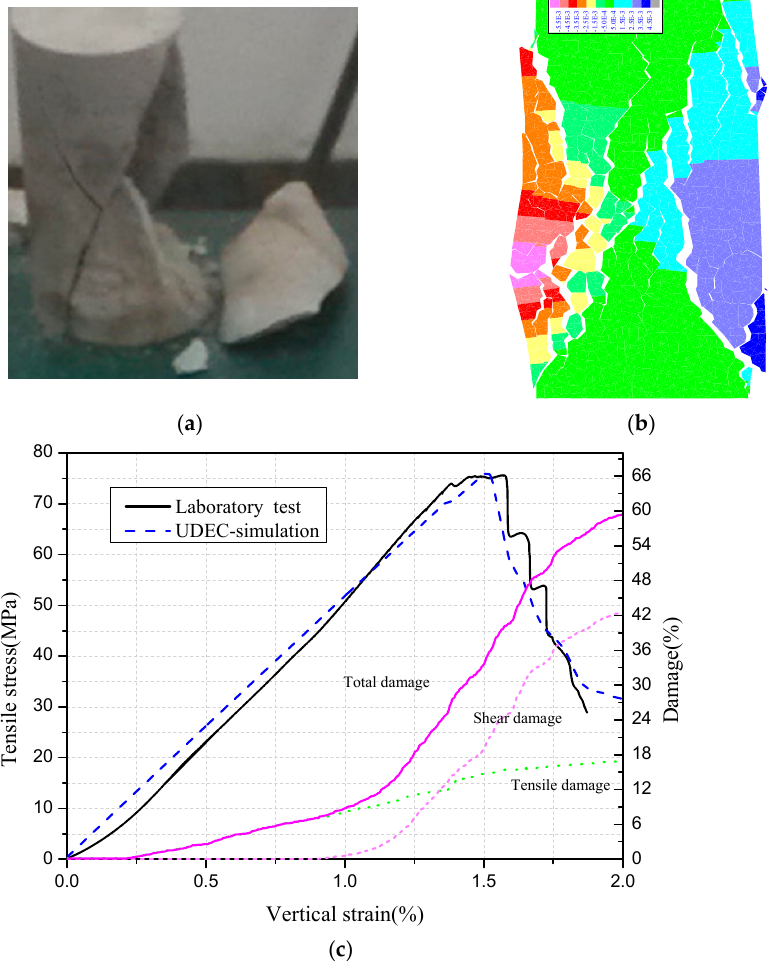
Figure 6. Calibration of the numerical model to the uniaxial compression tests: ( a ) failure pattern of the laboratory sample; ( b ) failure pattern of the numerical model; and ( c ) stress–strain curve of the numerical model.